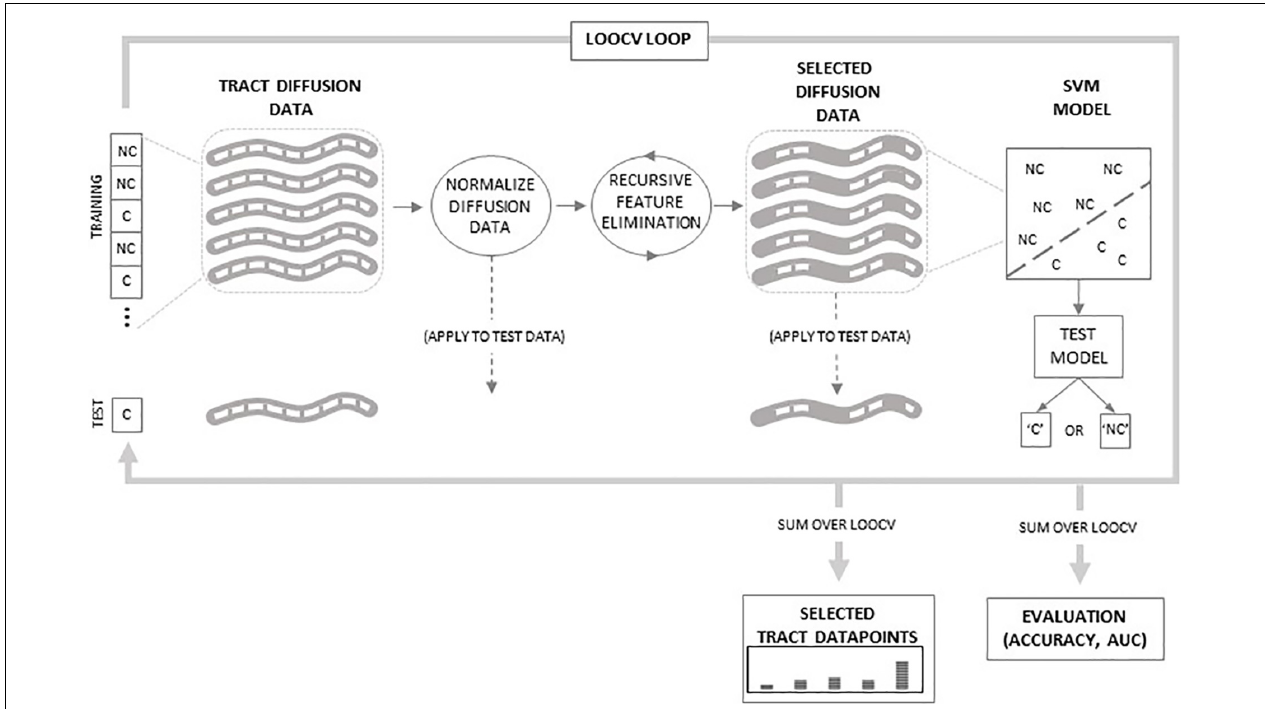
FIGURE 1 | Schematic of classification procedure. Within the leave-one-out cross-validation (LOOCV) loop, tract diffusion data from N-1 subjects are normalized and then recursive feature elimination is applied to select specific datapoints used to train the support vector machine (SVM) model. The model is then tested on the tract data from the remaining subject. The LOOCV loops over all N subjects. Outside of the loop, classifications are summed to evaluate SVM accuracy and area under the curve (AUC) values. Additionally, selected datapoints are summed to determine which regions along the tract are selected by the RFE procedure.